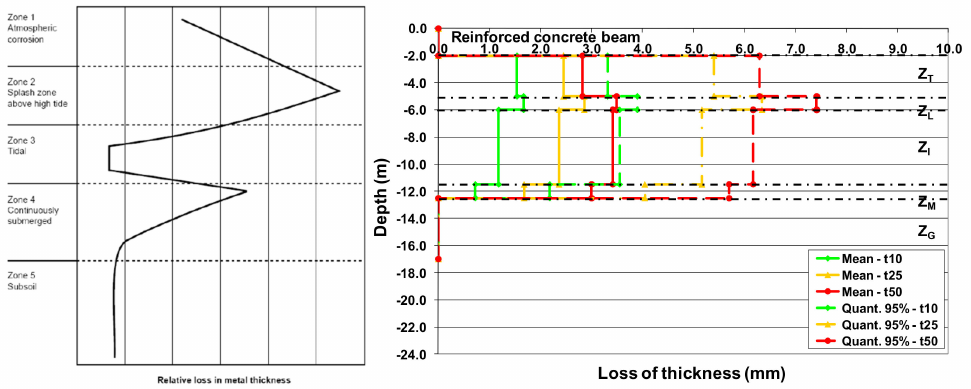
Figure 6. Typical profile of corrosion with depth (adapted from [24]) (left). Quantiles of the piecewise uniform corrosion model at two ages (10 and 25 years) (right-adapted from